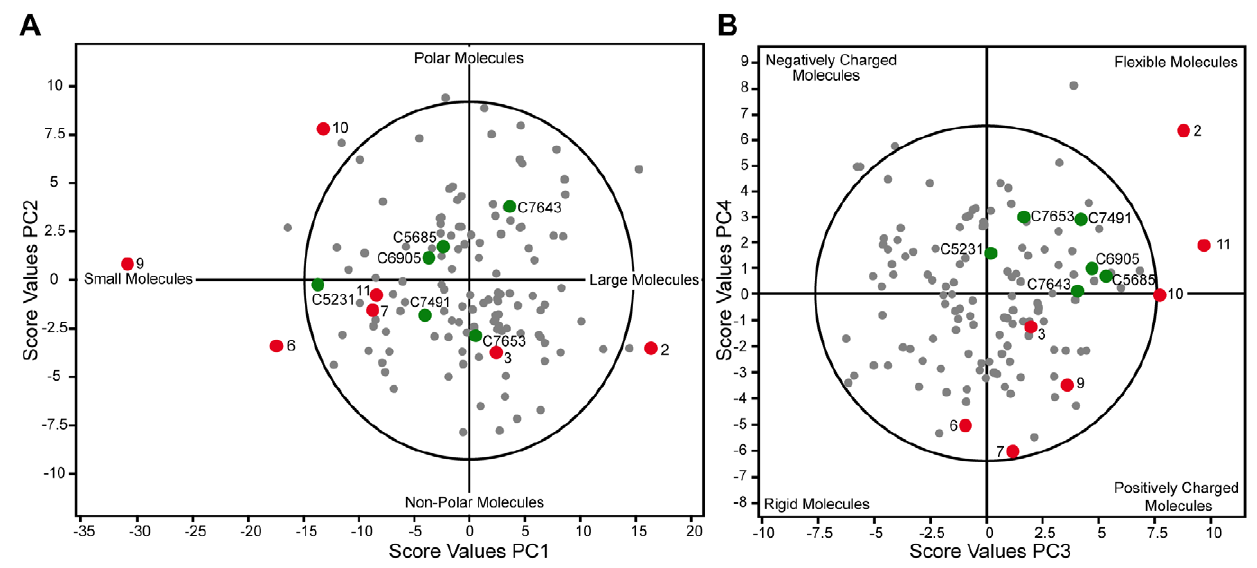
Figure 5. The chemical space of the identified AChE inhibitors. The chemical space was established by PCA of the physicochemical properties of the 124 hits (grey dots) that were identified in the HTS. The first and second PCs describe the size and polarity of the molecules (A), while the third and forth PCs illustrate the molecule’s distribution related to charge and flexibility (B). The hits for which crystal structures were successfully determined are shown in green and the known AChE inhibitors that were projected into the chemical space are shown in red ( 2 , 3 , 6 , 7 , and 9 – 11 ; see Figure 1 for chemical structures). Hotelling’s T2 (95%) is visualized as circled solid line.